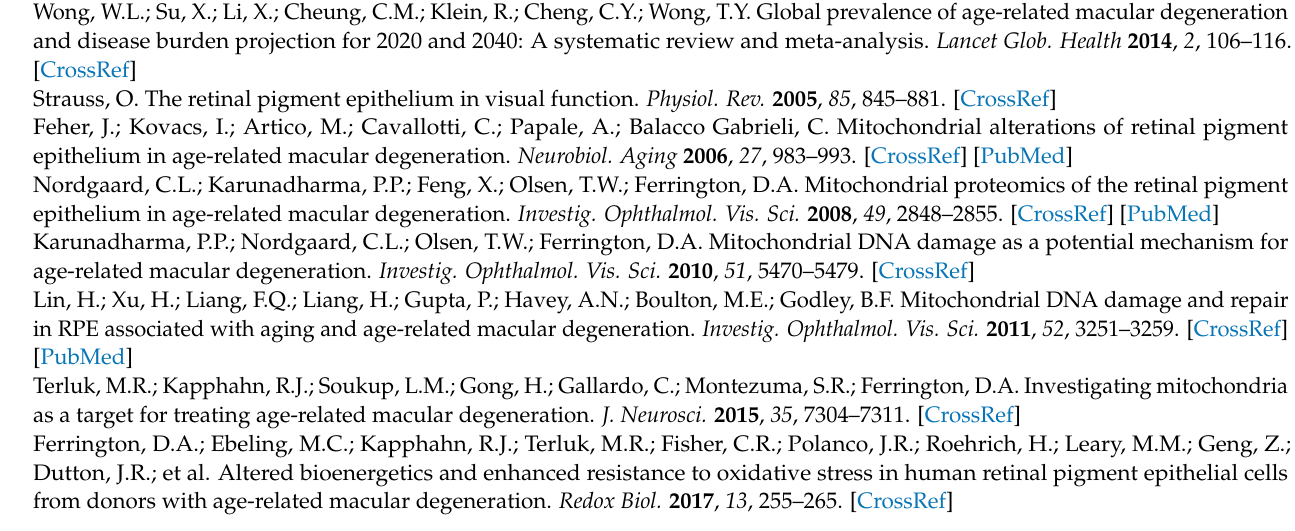
Figure 4, Figure S3: AICAR does not cause a shift in metabolism, Table S1: AMD donor iPSC-RPE demographics, Table S2: List of antibodies used in this